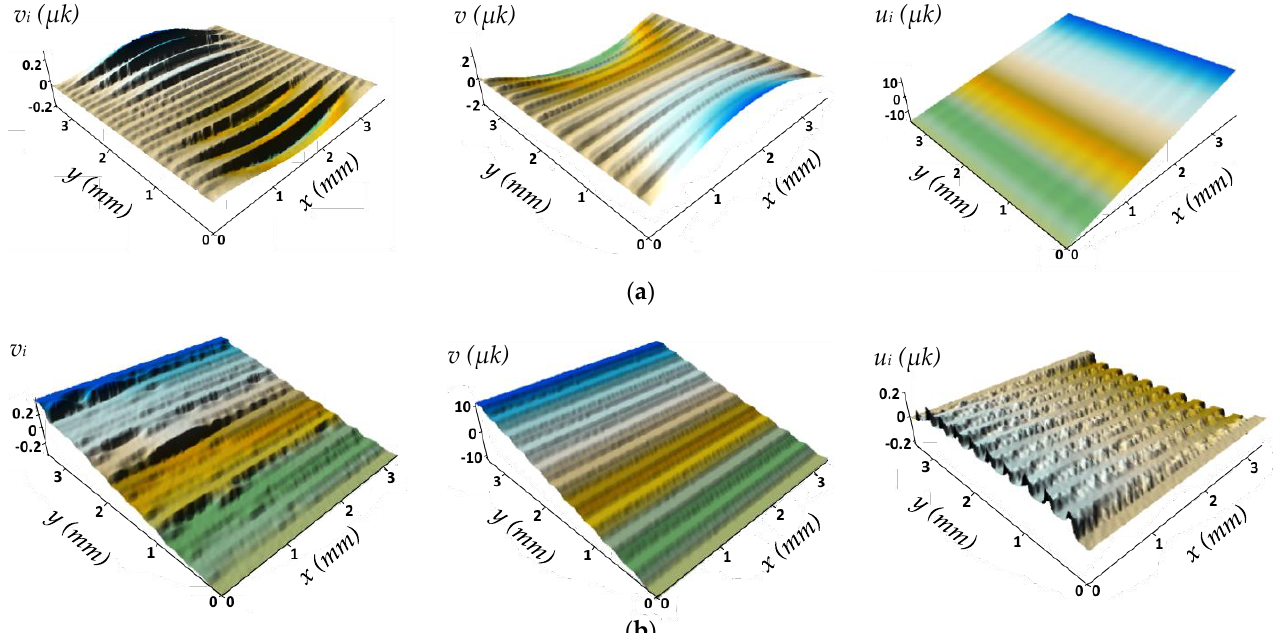
Figure 14. The computational domain with FEM mesh and displacement surfaces under tension: ( a ) along CF; ( b ) across CF with the 60/40 vol. % fiber-polymer ratio ( v i —along the y -axis at one step and v —total, u —along the x -axis).